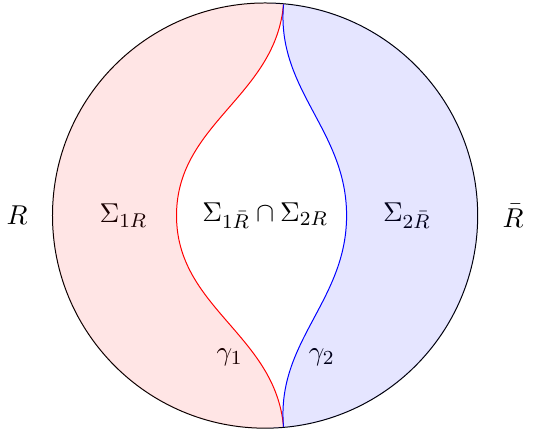
Figure 2 . An illustration of two competing RT surfaces γ 1 and γ 2 near a phase transition. In